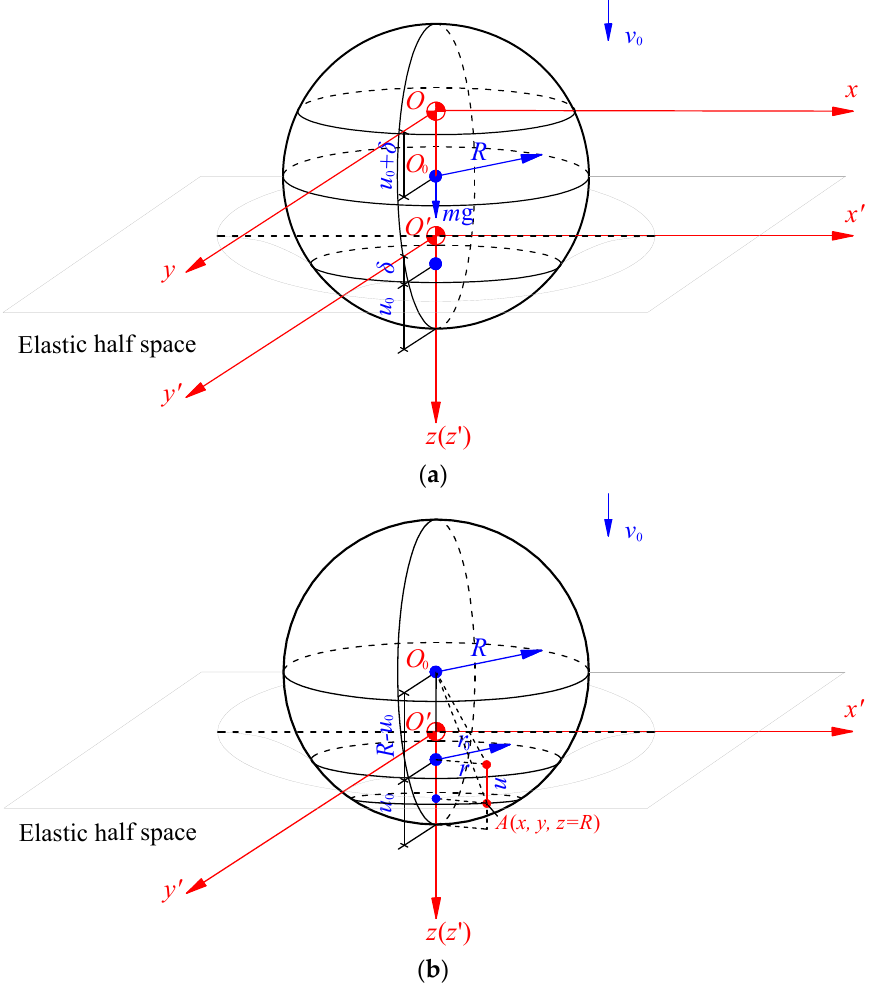
Figure 1. Physical model diagram of collision between the rigid sphere and elastic half-space: ( a ) schematic diagram of the coordinate system; ( b ) the geometric relationship between the vertical displacement of the collision contact surface and the vertical displacement of the